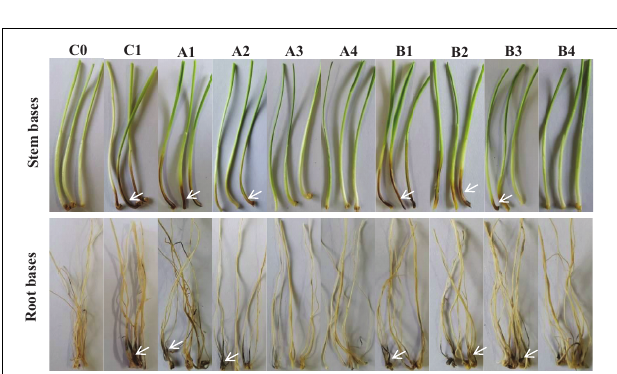
FIGURE 4 | Detection of G. graminis var. tritici hyphae viability based on fluorescein diacetate (FDA) and propidium iodide (PI) staining after treatment with Fengycin and Iturin A for 7 days. Live fungal cells with intact membranes show blue fluorescence, and fungal cells with damaged membranes show red fluorescence; sterile water served as the control (CK). The damaged sites of the fungal cells membrane are labeled using arrows. The magnification was 1,000 × .